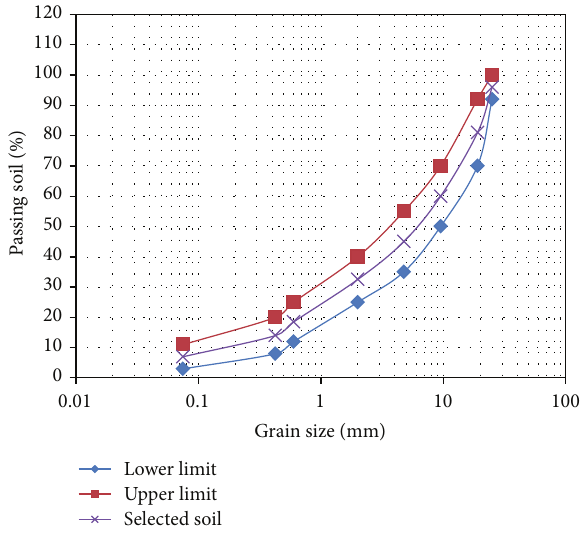
Figure 1: Grading curves for